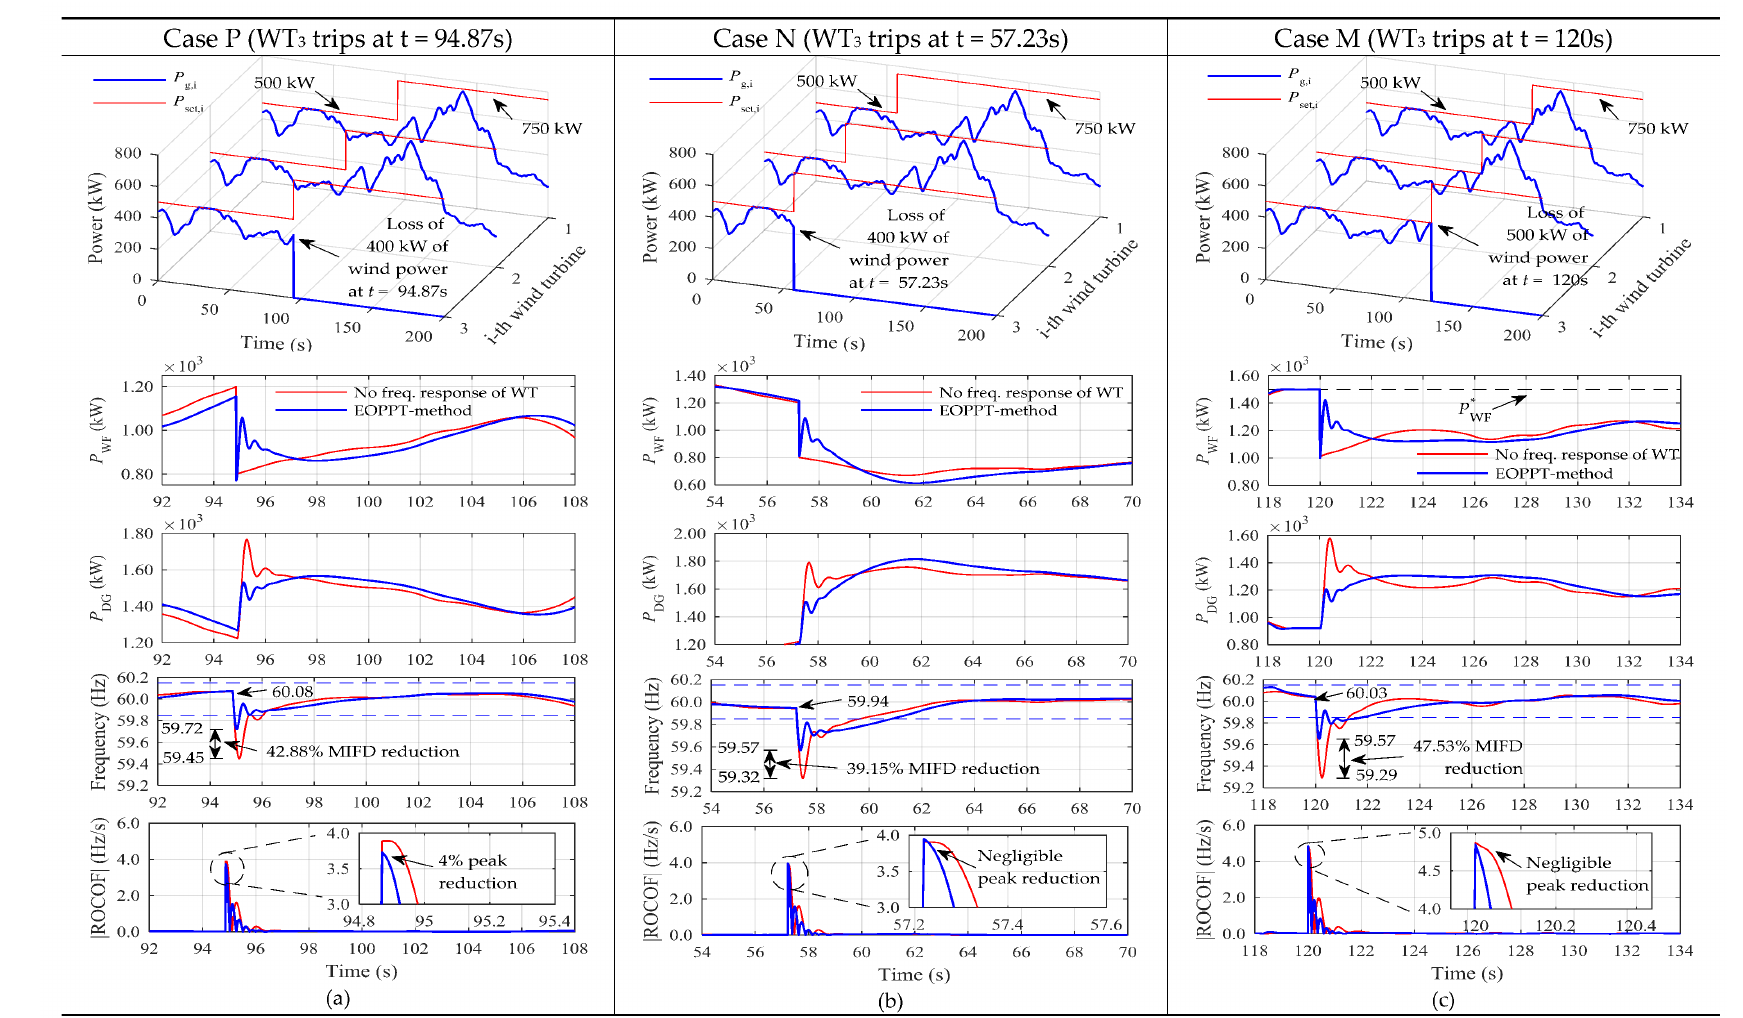
Figure 23. Power system response under different contingency scenarios: ( a ) Case P; ( b ) Case N and ( c ) Case